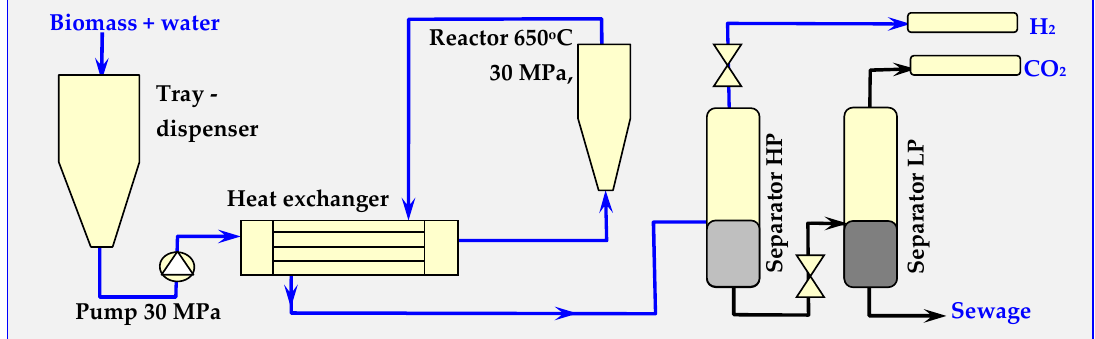
Figure 24. Scheme of the Power Transfer Unit (PTU) pilot installation in Enschede [17,184,185].